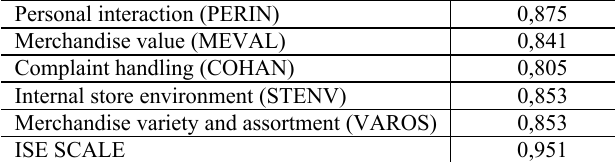
Table 10: Reliability results